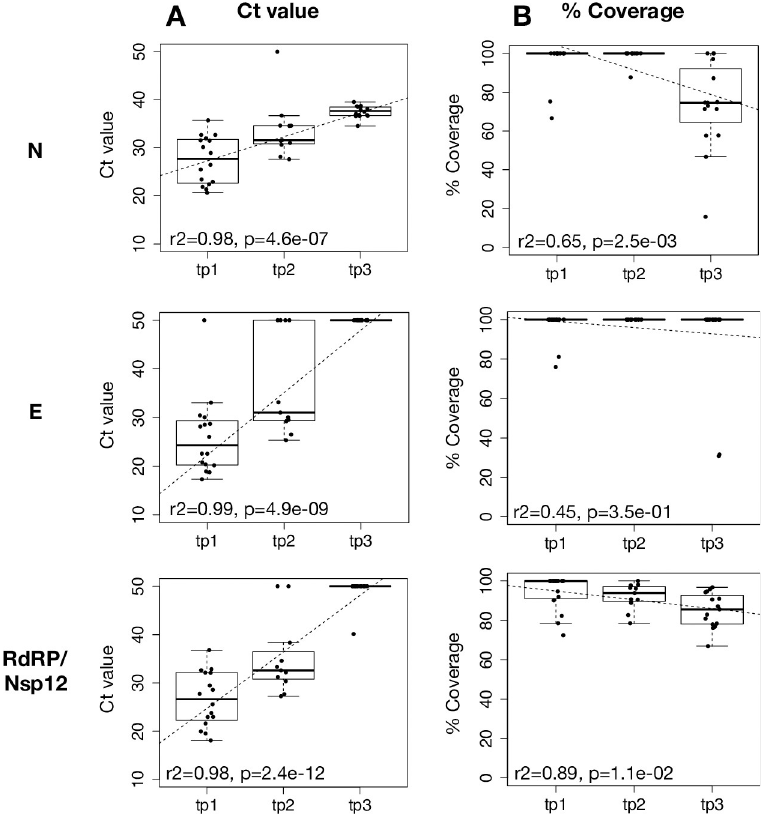
Fig 2. Genome coverage and viral mapped reads. Ct values of N, E and RdRp reactions obtained using the Allplex 2019-nCoV assay, plotted against SARS-CoV-2 complete genome coverage (% coverage, red triangles) and number of reads mapping to the viral genome normalized by the total number of reads per sample (% mapped reads, blue squares). Dotted lines represent linear regression per each measured quantity, with the coefficient of determination (r2) and T-test p value (p) denoted in the figure legend. The inserts summarize the Ct values obtained for each of the time points